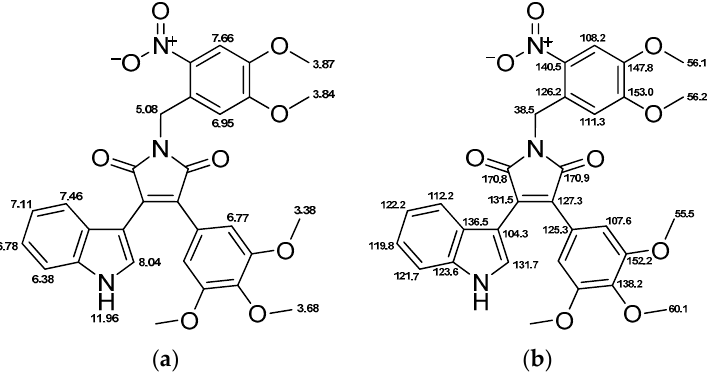
Figure 11. Chemical structure of 4 and relevant NMR shifts for ( a ) 1 H-NMR; and ( b ) 13 C-NMR.